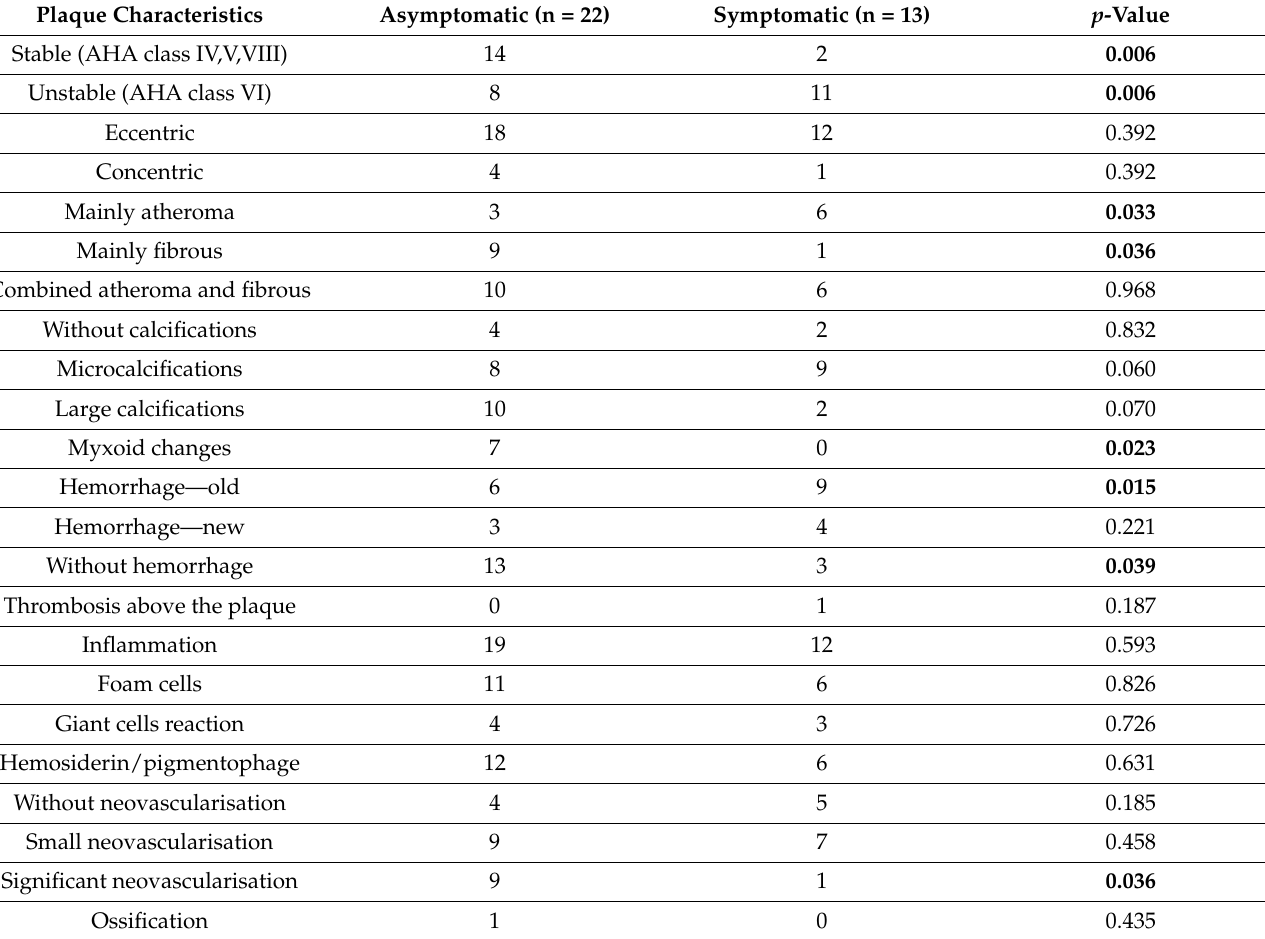
Table 2. Histological features and AHA classification of carotid plaques based on the criteria of symptomatology by NASCET and ECST. p -value of statistical significance is highlighted.